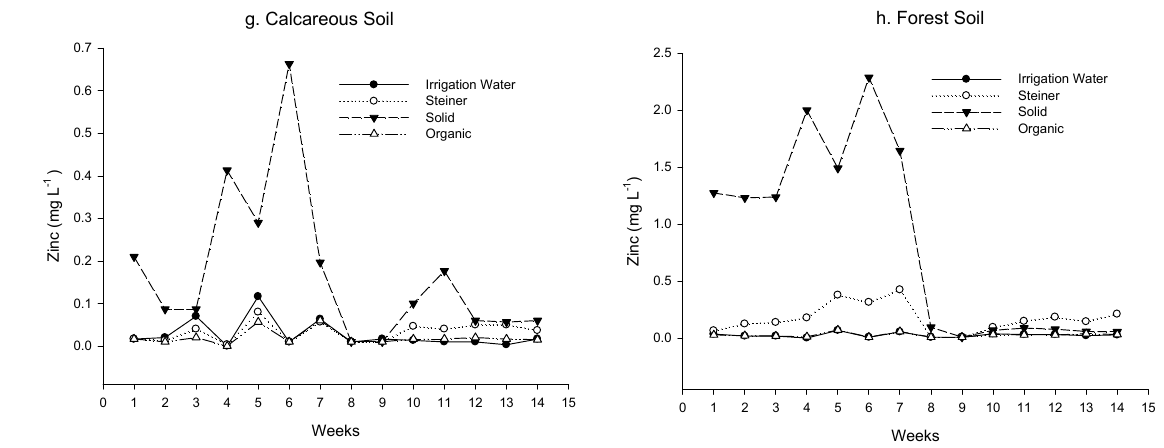
Figure 5. Dynamics of electrical conductivity, nitrates, sulfur, and zinc, determined in samples of soil solution for calcareous and forest soils under pot and greenhouse conditions under different nutrient supply scenarios, using the Inorganic: nutrient solution (Steiner) fertilizers and fertilizers in fractional form (solid) and organic fertilizer with vermicompost tea (aqueous extract).